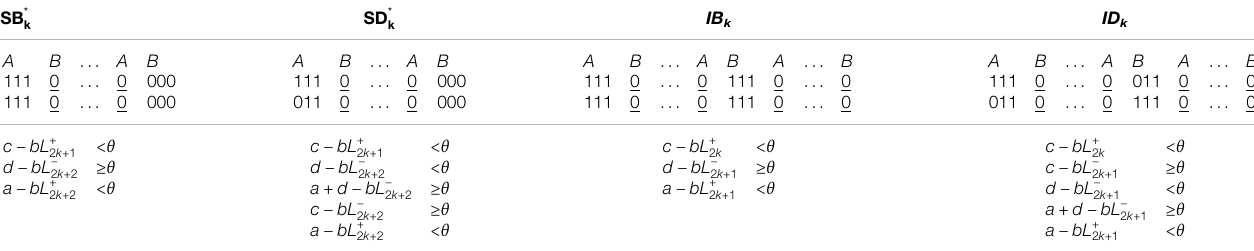
TABLE 3 | Name, matrix form and existence conditions of cycle skipping MAIN states (* asymmetrical states). SB * k SD *